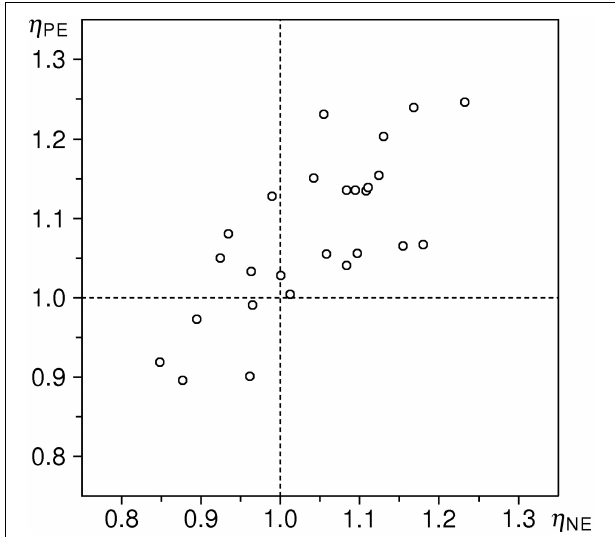
FIGURE 6 | Correlation plot of estimated flow ratios η NE versus η PE ( n = 26, R = + 0 .